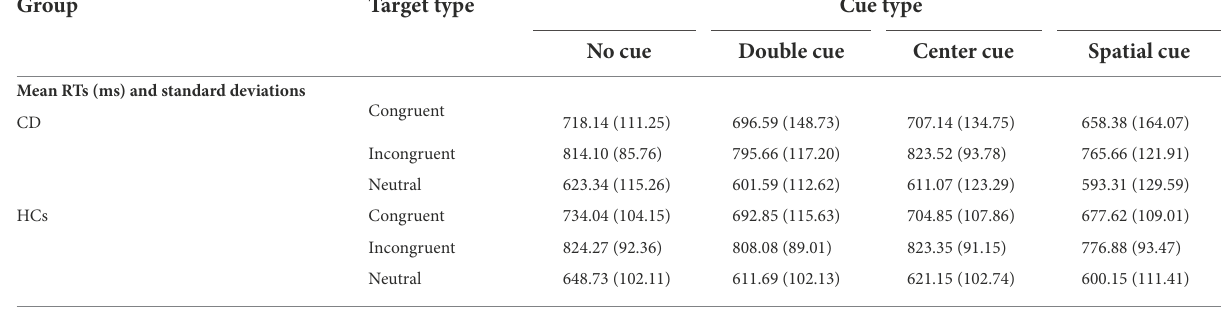
TABLE 2 Mean RTs under each condition in patients with CD and HCs.